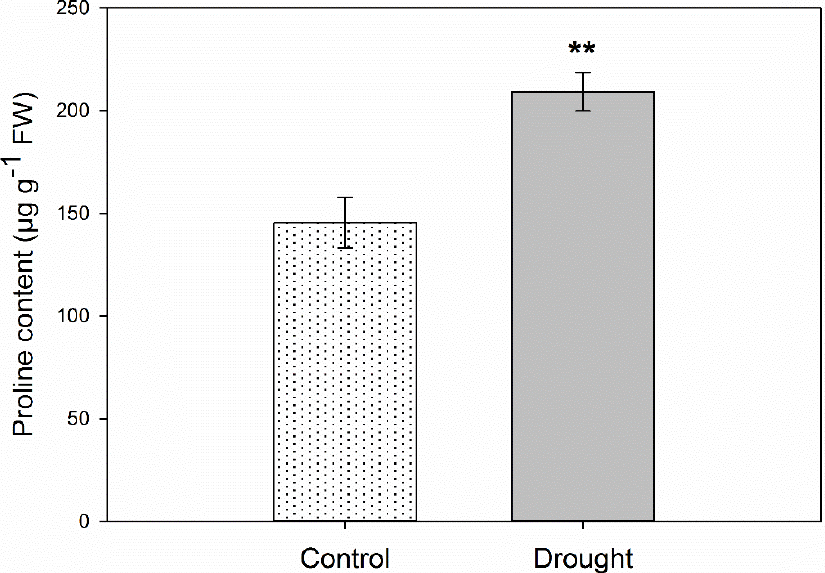
Figure 1. Soil drought stress increases proline content in flower abscission zone (AZ) of yellow lupine. Lupines were cultivated under water deficit conditions (25% WHC), while control plants were grown in the soil of optimal moisture (70% WHC). For analysis, sections of the abscission zone (AZ) were collected on the 48th day of cultivation. Data are presented as averages ± SE ( n = 3). Significant differences in stressed plants in comparison to control are ** p < 0.01 (Student’s t -test).